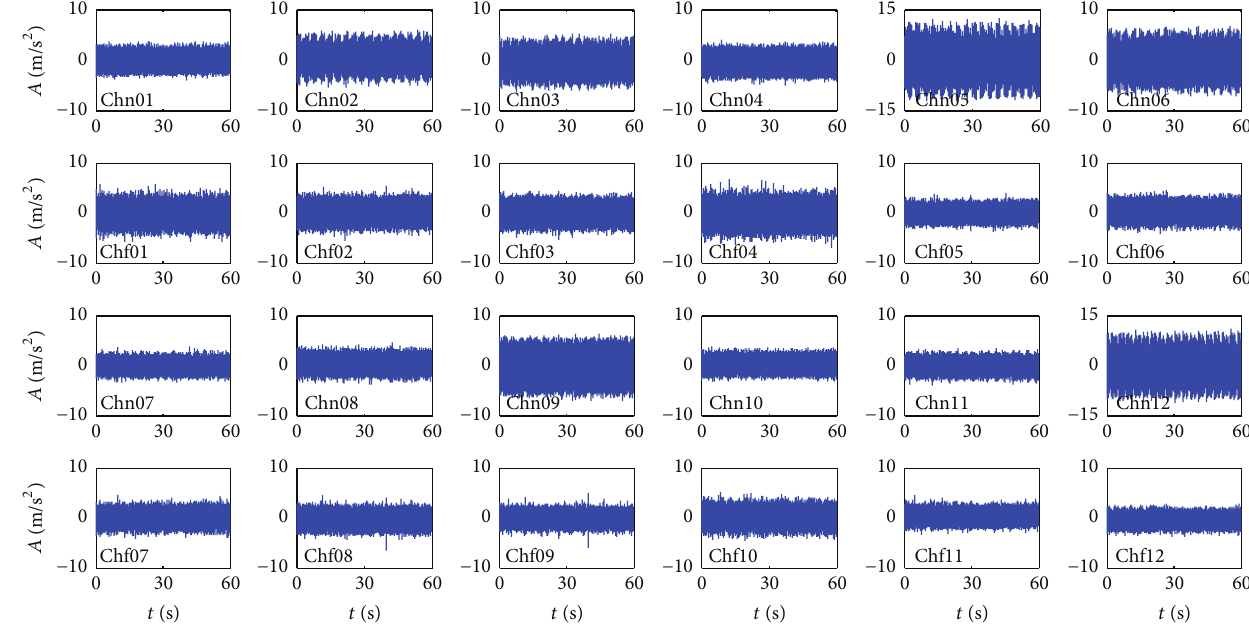
Figure 8: Time signals.